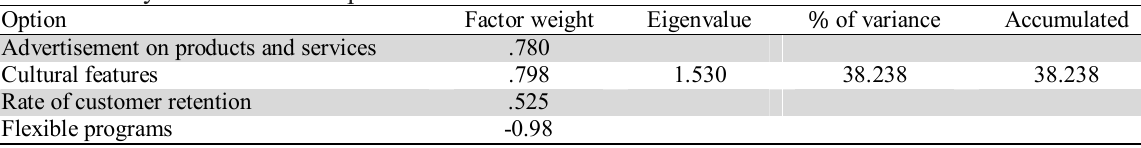
Factor weight Eigenvalue % of variance Accumulated .780